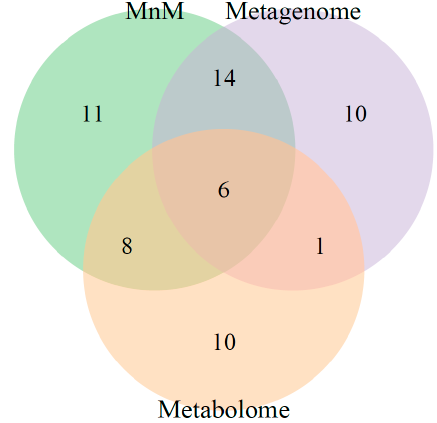
Figure 3. Venn diagram summarizing the number of significant pathways shared among three methods, HisCoM-MnM, metagenome, and metabolome. The number of significant pathways in the Venn diagram was determined by Bonferroni-corrected p -values with a cutoff 0.01.